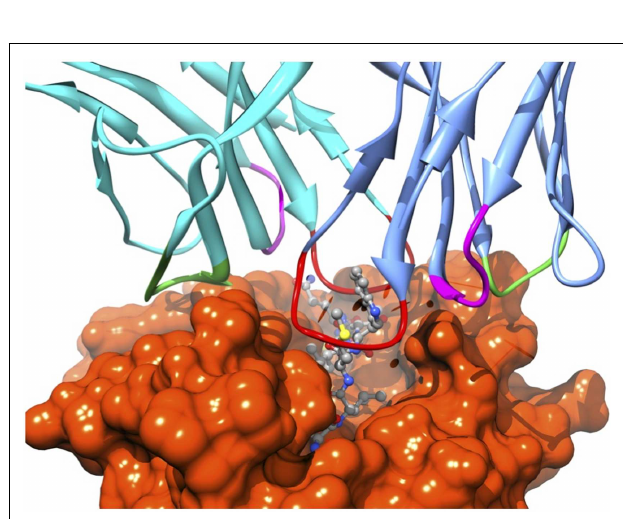
FIGURE 2 | Position of theTCR CDRs over the pMHC surface . CDR1s, CDR2s, and CDR3s are colored in magenta, green, and red, respectively.